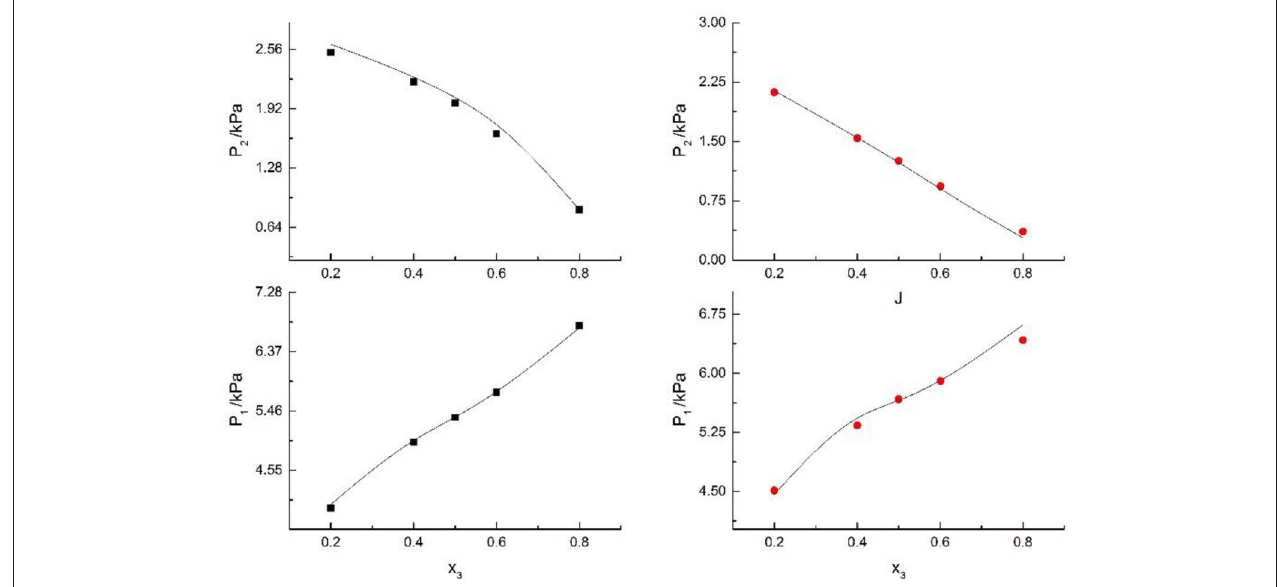
FIGURE 4 | Correlation of VLE data of H2O(1) + CH3OH(2) + CaCl2(3) system. Filled symbols ( (cid:4) x2 = 0.05 and T = 298.15K; • x2 = 0.15 and T = 298.15K) indicate literature data (Kumagae et al., 1992); curves indicate correlation of the